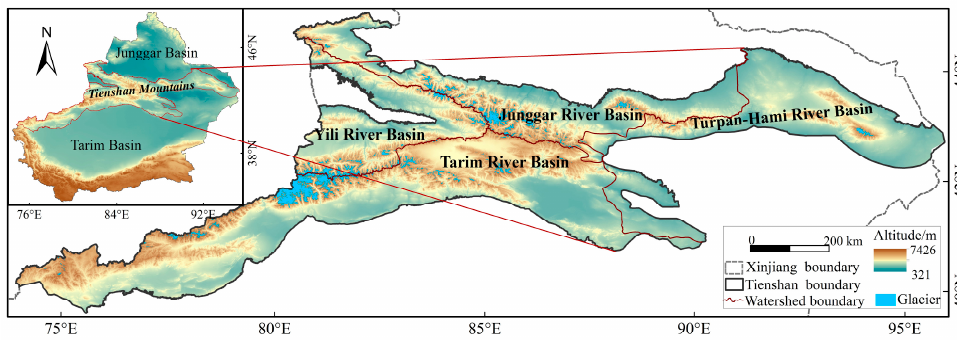
Figure 1. Location of the study area in China